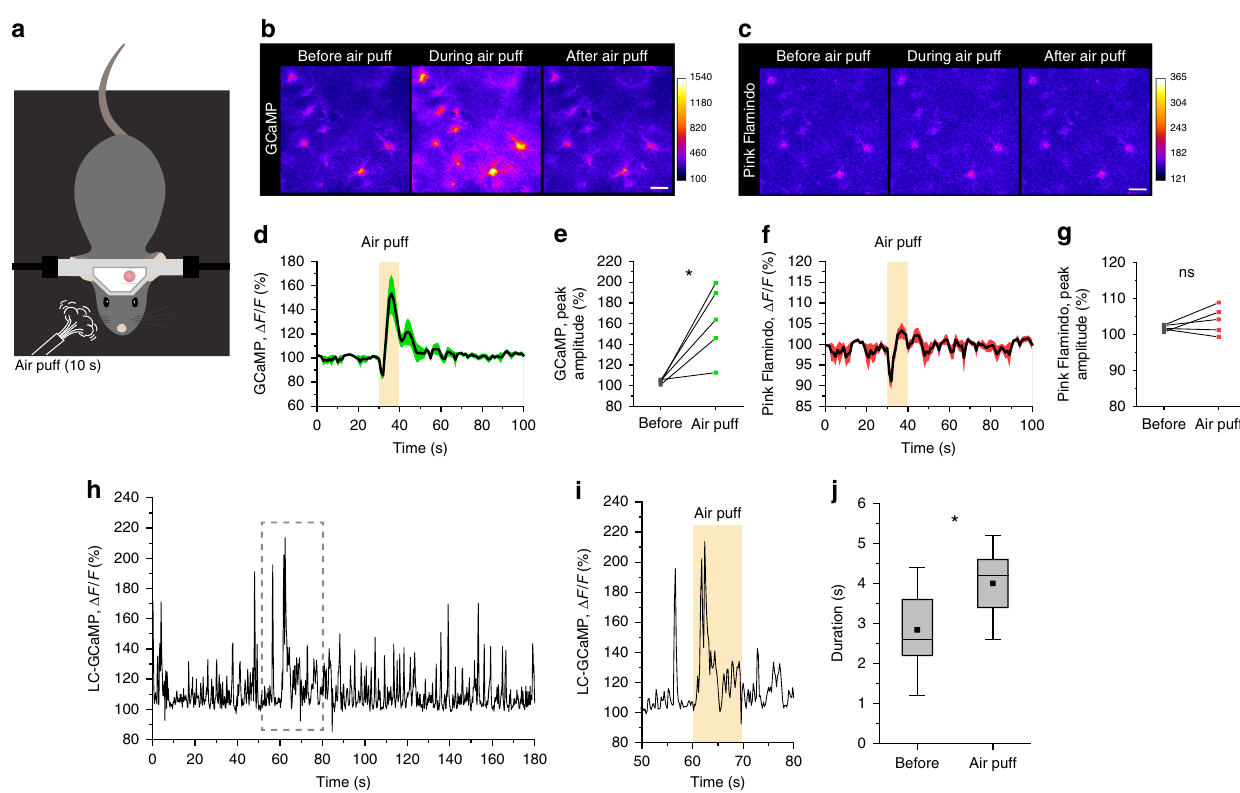
Fig. 5 Startle by abrupt air-puff stimulation induces astrocytic Ca 2 + elevations and LC/NA axon multipeak Ca 2 + signals without a cAMP surge. a Illustration of air-puff stimulation under two-photon microscopy. b , d , e Astrocytes show clear Ca 2 + elevations by facial air-puff stimulation ( b ). Air puffs presented for 10 s induce signi fi cant Ca 2 + increases ( d , e ; n = 5 sessions, 3 mice). c , f , g Astrocytes do not show detectable cAMP signal changes by air puff ( n = 5 sessions, 3 mice). h , i Ca 2 + activity of LC/NA axons in the cortex was imaged for 3 min ( h ). The period during air puff was magni fi ed ( i ), which shows a clear MP signal. j Duration of multipeak signals between before air puff (0 – 60 s) and during air puff (60 – 70 s) ( n = 4 sessions, 4 mice). Scale bars 20 μ m. Analysis was performed from average of individual sessions in e and g and from individual MP signals in j . Box plots: box range, 25 – 50 – 75% quatile; square, mean; whiskers, max – min. paired t -test: e ; Student ’ s t -test with Welch ’ s correction: j ; * p <